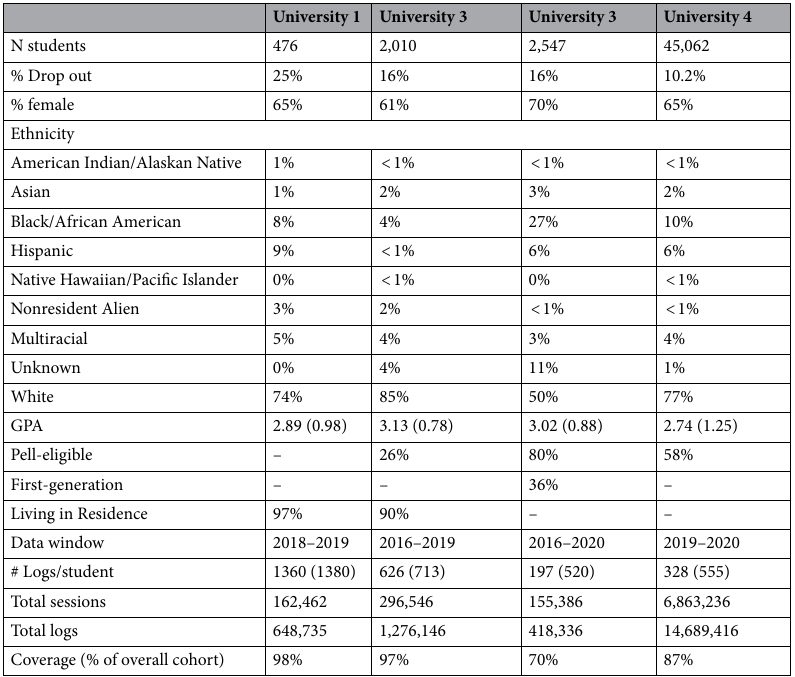
Table 1. Descriptive statistics of socio-demographic characteristics across the four